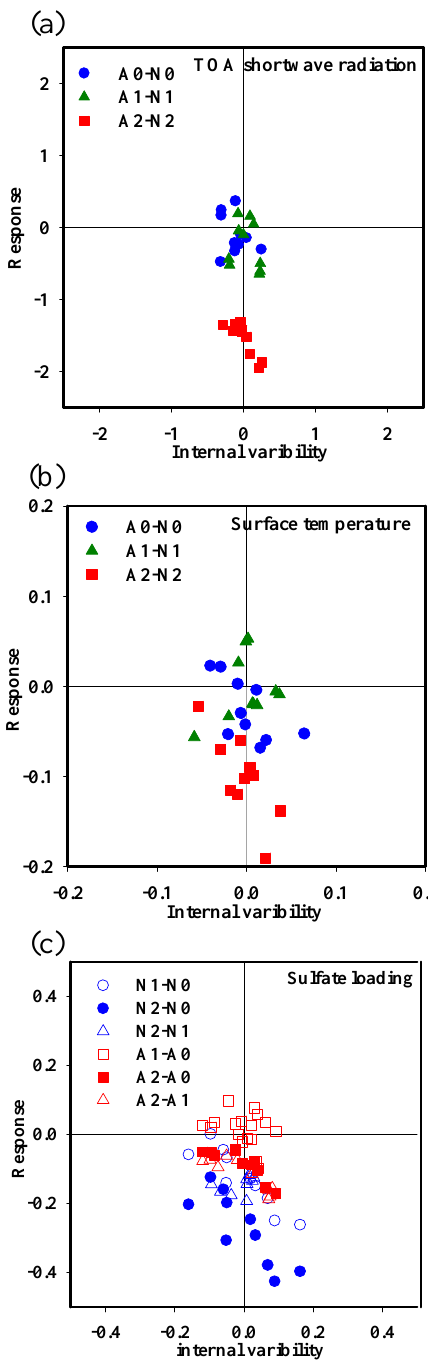
Fig. 7. Comparison between model internal variability (abscissa) and responses to sulfate forcing (ordinate). (a) Global mean TOA radiative forcing (in W m − 2 ); (b) Near-surface temperature (in K); and (c) Sulfate loading (in mg m − 2 ). The internal variability is de- fined as the annual variation of the reference case, which is chosen as the subtrahend of the two simulations being compared (e.g., N0 in